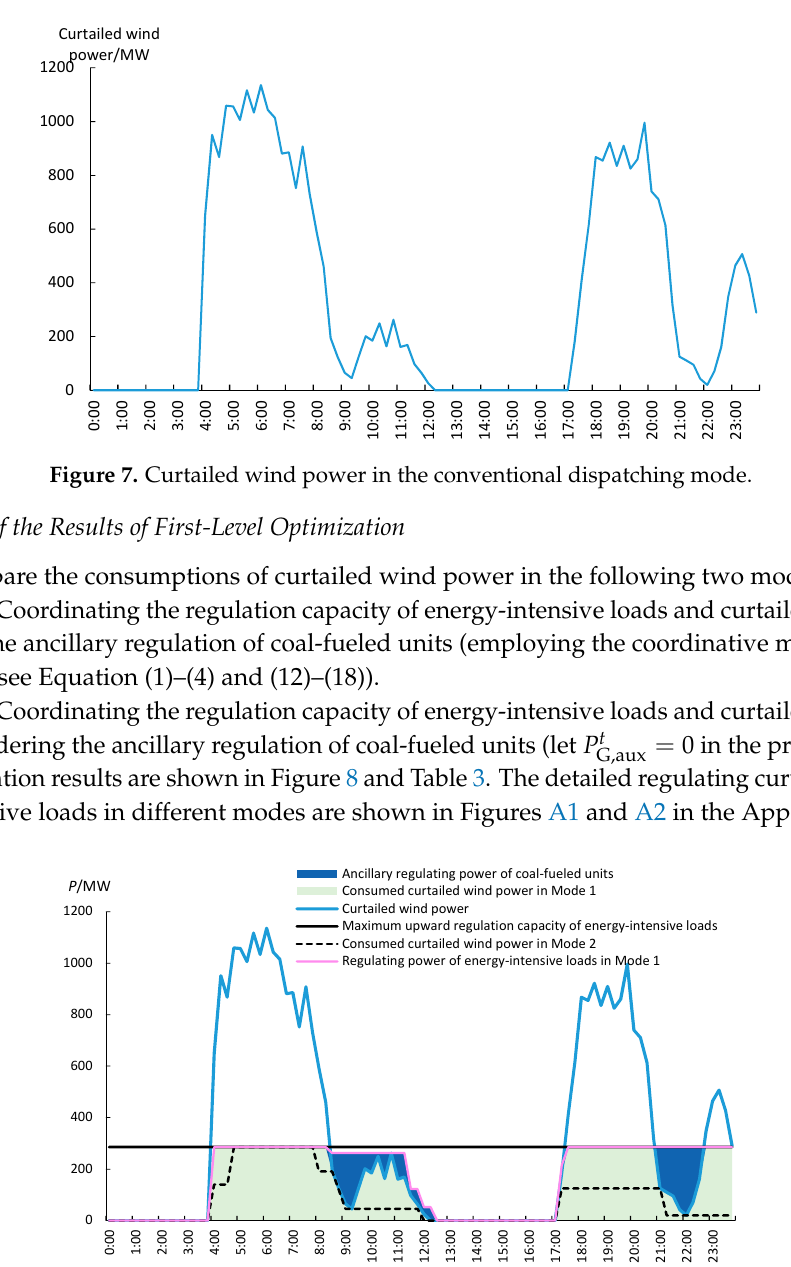
Figure 7. Curtailed wind power in the conventional dispatching mode.